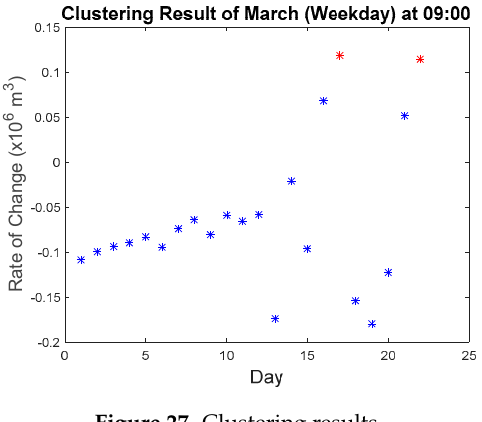
Figure 27. Clustering results.